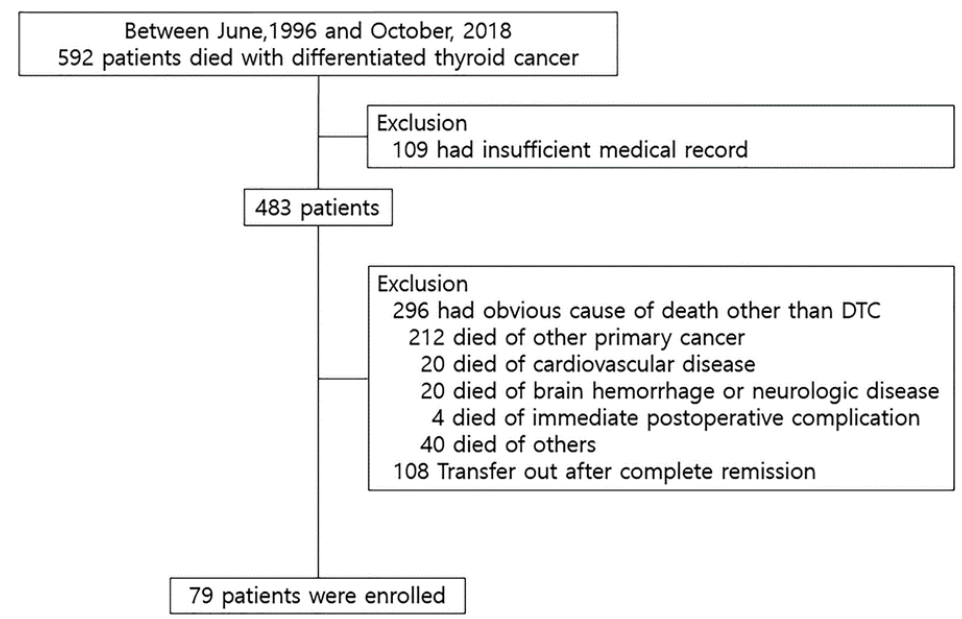
Figure 1. Study populations. DTC, differentiated thyroid carcinoma. Table 1. Causes of death in 483 patients who died with well-differentiated thyroid carcinoma.